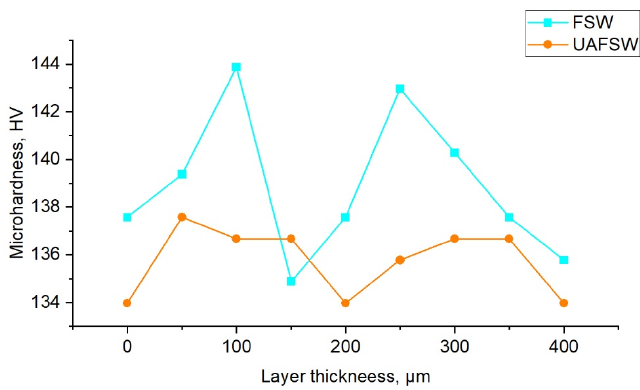
Figure 12. Microhardness line graph of FSW and UAFSW joints.